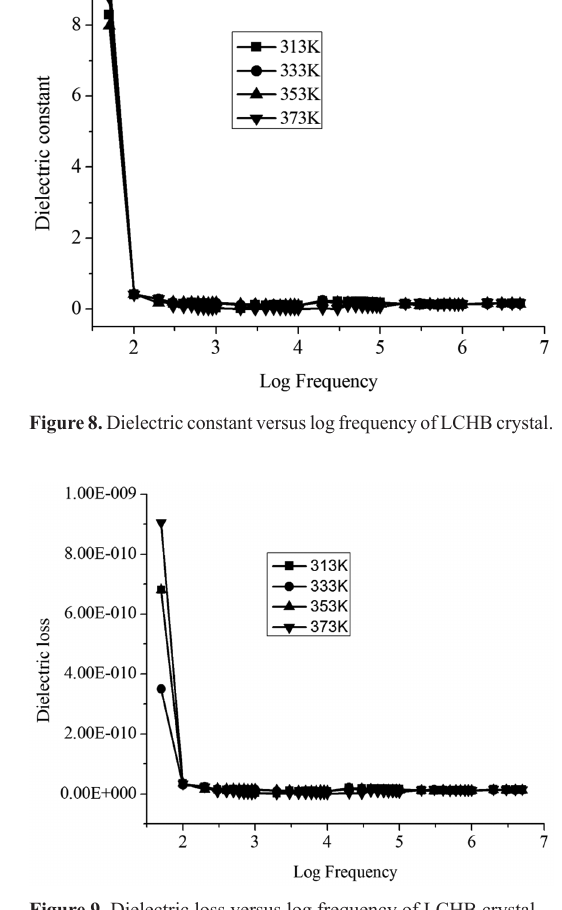
Figure 9. Dielectric loss versus log frequency of LCHB crystal.